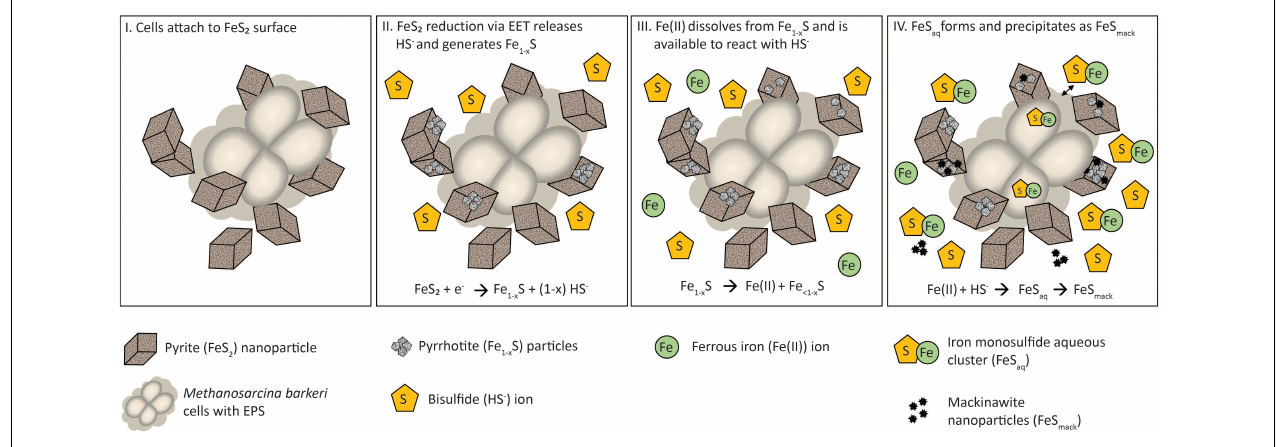
FIGURE 9 | A model for Methanosarcina barkeri growth on pyrite (FeS 2 ). See main text for description. EPS, or mineral, thereby enhancing EET to FeS 2 (Step 4).